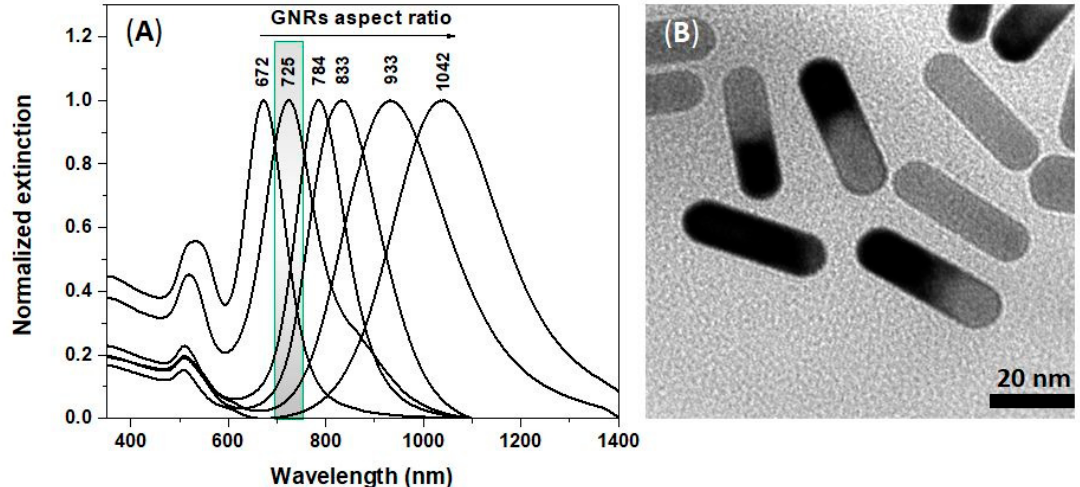
Figure 1. ( A ) Normalized UV-Vis-NIR extinction spectra of the synthetized GNRs in aqueous solution with different aspect ratios racing from 2.5 to 6.2; ( B ) representative TEM image illustrating the selected cetyltrimethylammonium bromide (CTAB)-stabilized GNRs at 725 nm.